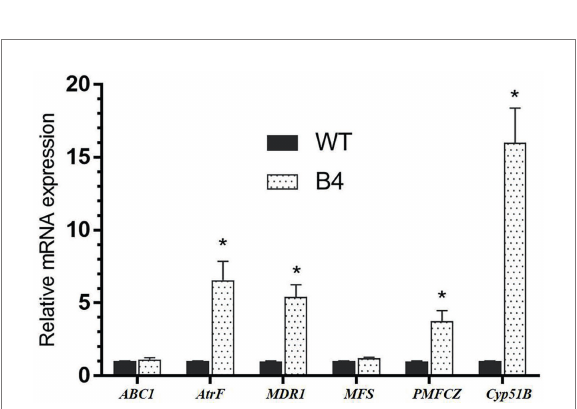
Gene expressions of important drug-related genes in WT and B4. * p < 0.05 compared with the